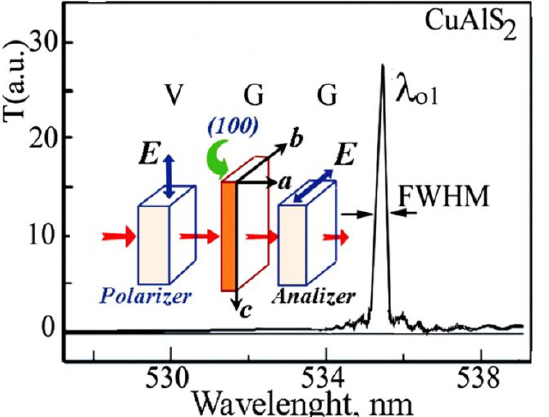
Figure 9. Transmission spectrum of CuAlS